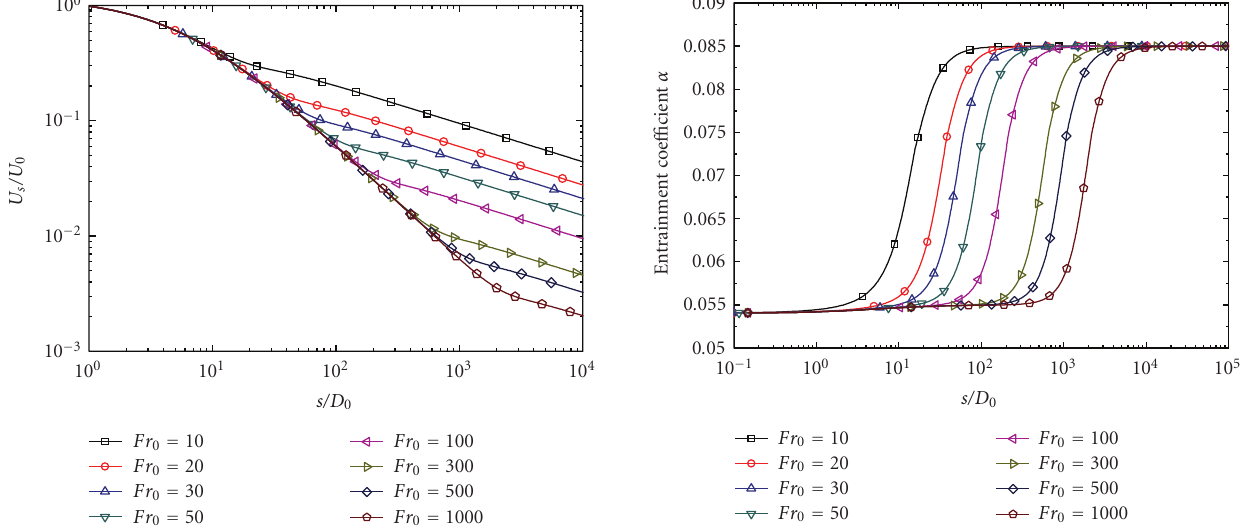
Figure 8: Entrainment coe ffi cients of horizontal buoyant jet.